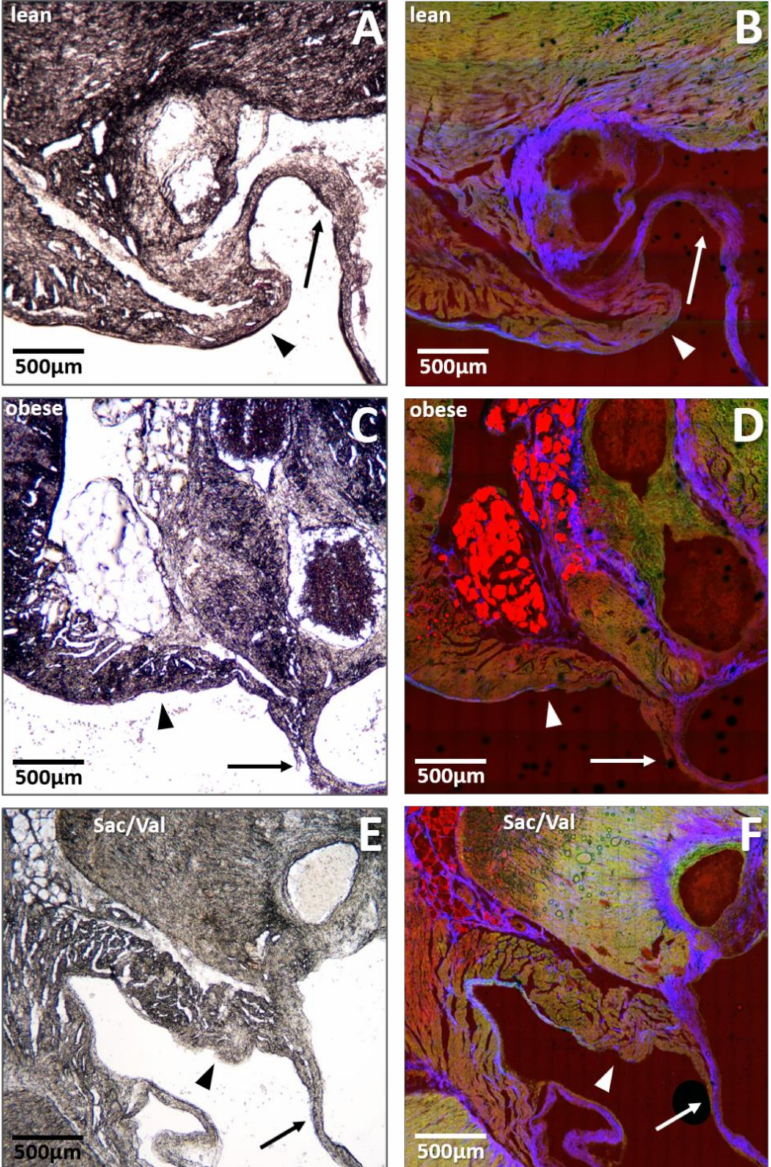
Figure 6. Comparison of LV fat deposits at the site of the mitral valve annulus after 12 weeks of Sac/Val. Brightfield microscopy ( A , C , E ) and nonlinear optical microscopy (NLOM) ( B , D , F ) of representative heart sections of a lean ( A , B ), an obese ( C , D ), and a Sac/Val treated obese rat ( E , F ). Arrows point to mitral valve structures. Arrow heads indicate the mitral valve annulus. NLOM visualizes collagen fibers (appearing in blue), myofilaments (appearing in green), and lipid structures (appearing in